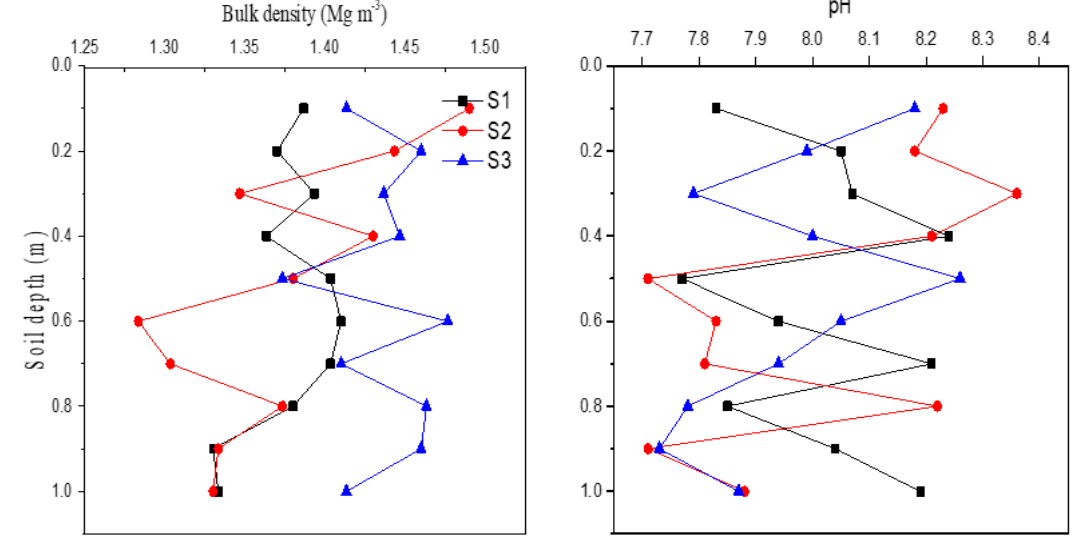
Figure 2. Measurement of bulk density and pH in sediment cores near the constructed dam. (S1: upper-dam; S2: middle- dam; S3: bottom-dam positions).